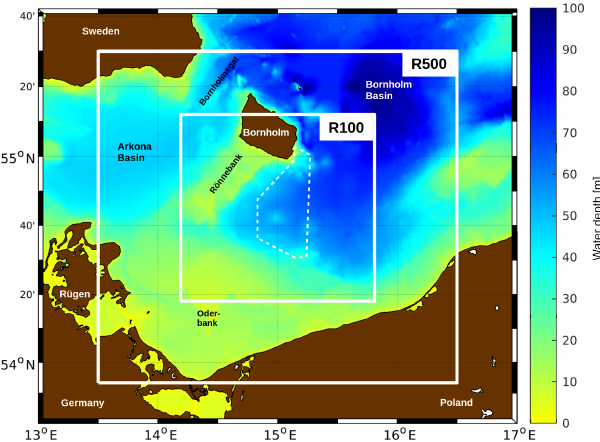
Figure 1. The R500 and R100 model domains in the western Baltic Sea. The approximate experimental area of Expedition Clockwork Ocean is indicated by the dashed